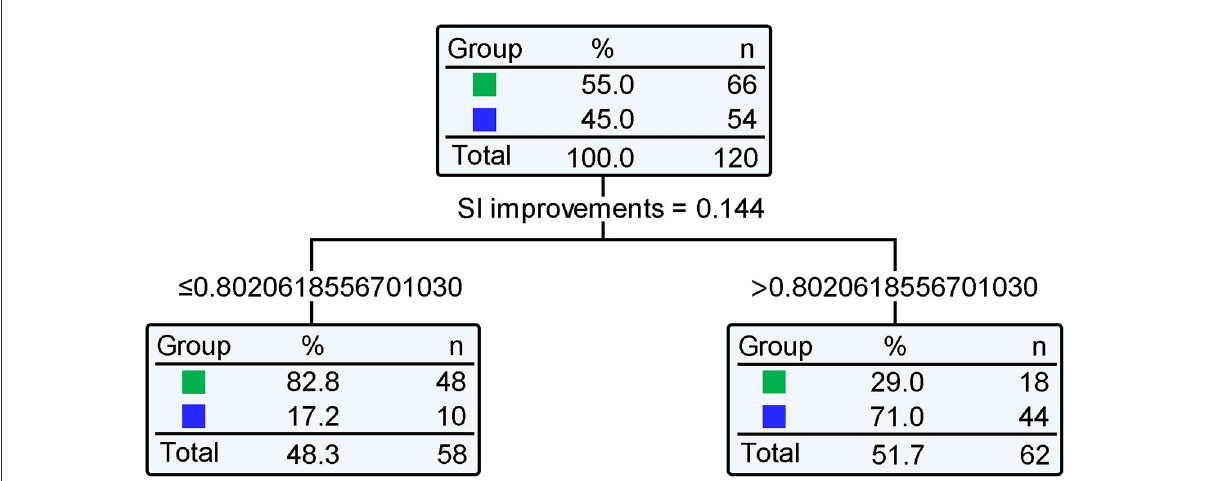
FIGURE2 Classification and Regression Tree of the risk of cerebral hernia patients with PTCI. Standardized importance analysis showed that SI was the primary influencing factor for PTCI. Taking SI as the independent variable and cerebral infarction as the dependent variable, the predictive value of cerebral infarction in patients with traumatic brain hernia showed that the optimal SI cut-off point was 0.802.